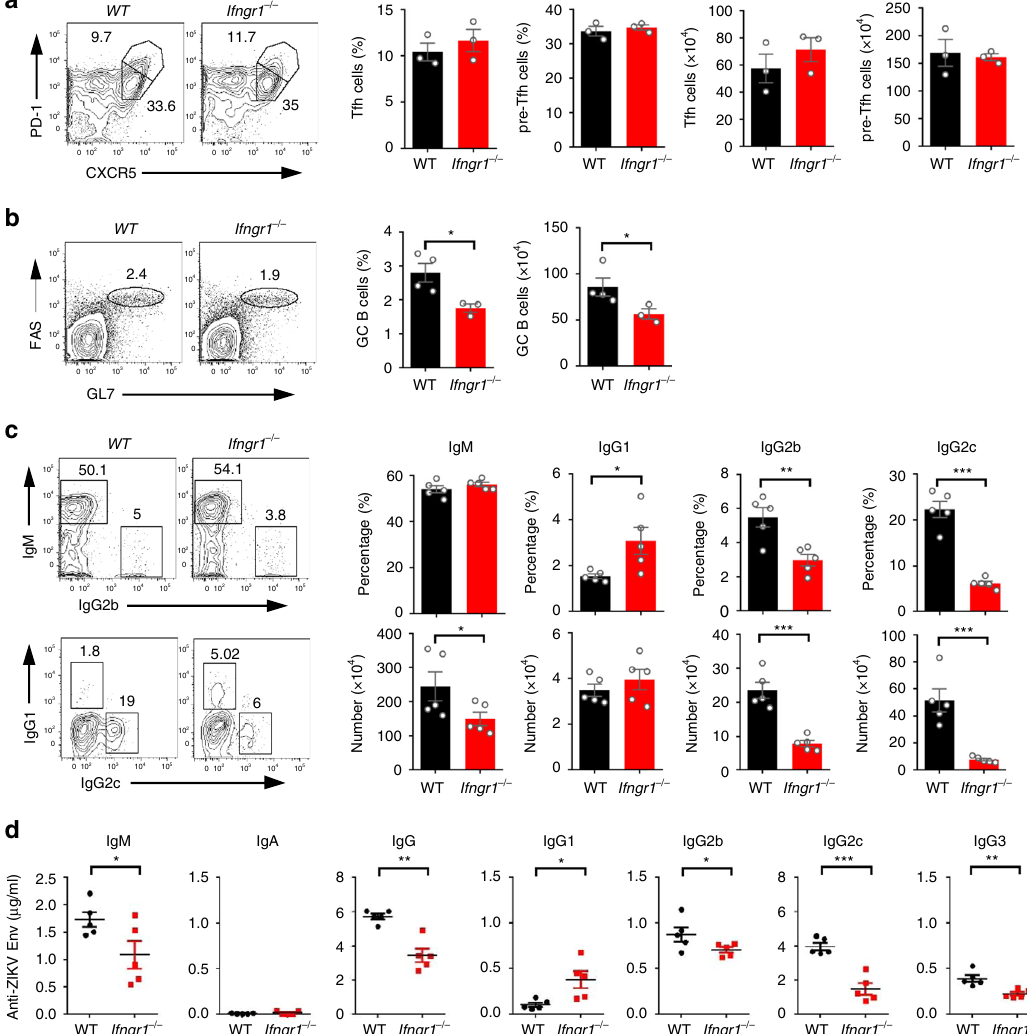
Fig. 7 The IFN- γ pathway is required for IgG2c antibody class switching. a – d WT mice and Ifngr1 − / − mice were infected by ZIKV with anti-IFNAR1 blocking antibody at one day prior to infection. Splenocytes were collected for measurement of Tfh and GC B cell responses on 7 dpi and antibody-producing B-cell responses on 14 dpi; sera were collected on 14 dpi for assessment of antibody responses ( n = 3 – 5 for each group). a Representative fl ow cytometry plots of CXCR5 high PD-1 high cells and CXCR5 medium PD-1 medium cells in CD4 + CD44 high CD62L low cells were presented as Tfh cells and pre-Tfh cells (left panel); bar graphs summarized the percentages and numbers of cells in each group. b Representative fl ow cytometry plots of FAS + GL7 + cells in B220 + B cells were presented as GC B cells (left panel); bar graphs summarized the percentages and numbers of GC B cells in each group (right panel). c Representative fl ow cytometry plots of IgM, IgG1, IgG2b, and IgG2c staining of IgD low B cells (left panel); bar graphs summarized the percentages and numbers of cells (right panel). d The concentrations of ZIKV envelope speci fi c IgM, IgA, total IgG, IgG1, IgG2b, IgG2c, and IgG3 antibodies in sera were determined by ELISA.